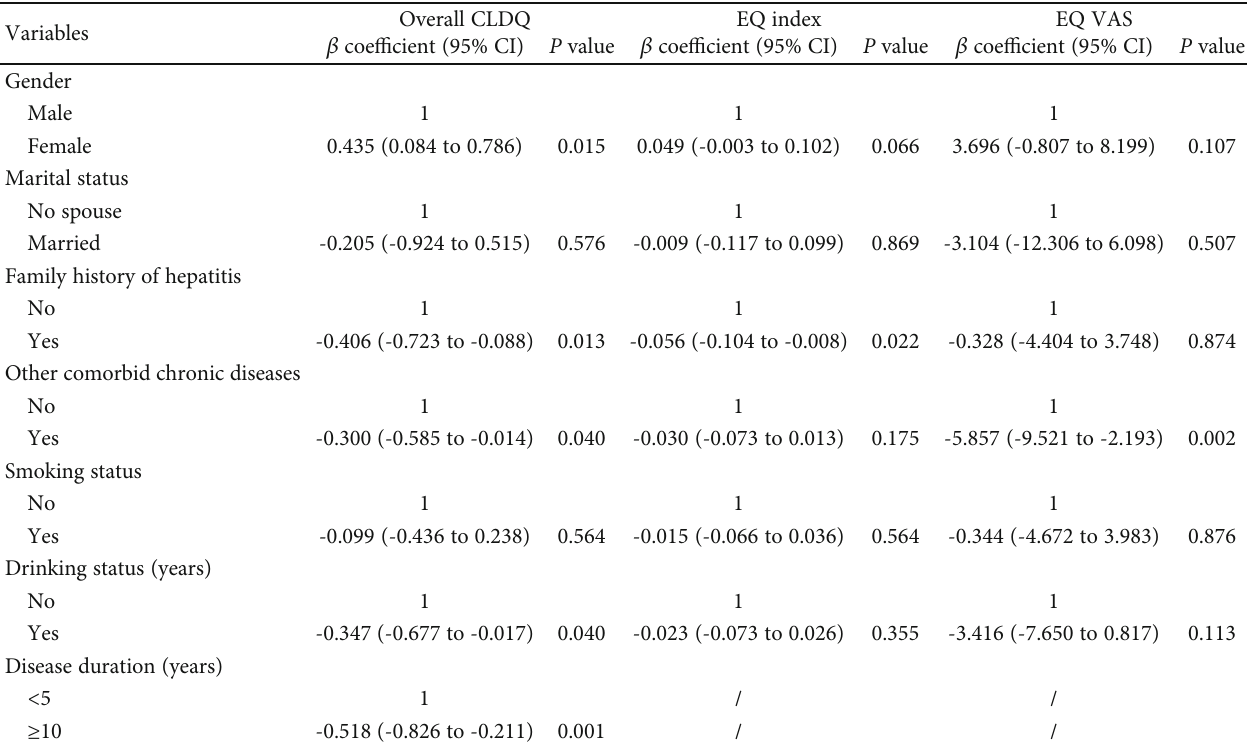
Table 4: Multivariate linear regression for predictive factors on the overall CLDQ scores and EQ-5D in patients with HCV infection (CHC and